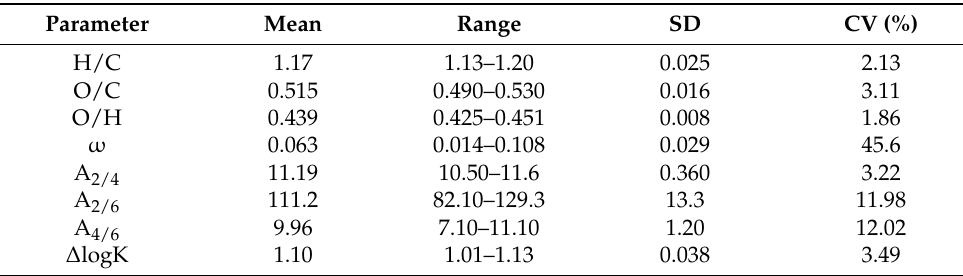
Table 6. Atomic ratio, degree of internal oxidation, and spectrometric coefficients of the HAs molecules isolated from spent mushroom